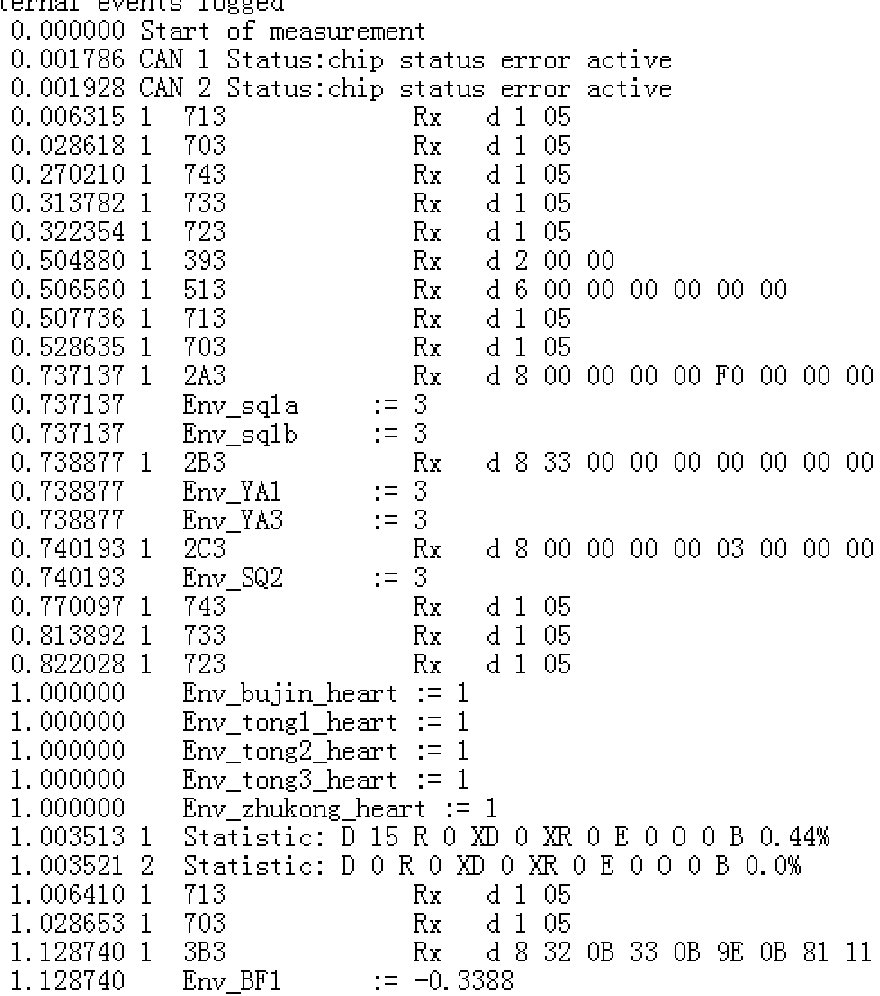
Figure 3. Information received from field bus network.